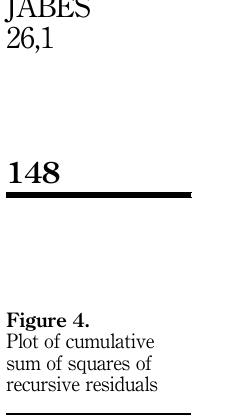
Figure 4. Plot of cumulative sum of squares of recursive residuals